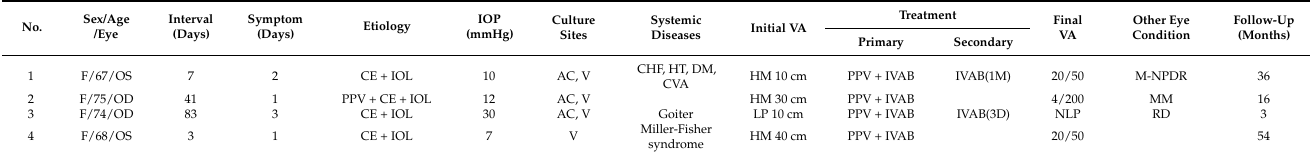
Table 1. Clinical summary of patients with postoperative endophthalmitis caused by S. lugdunensis .